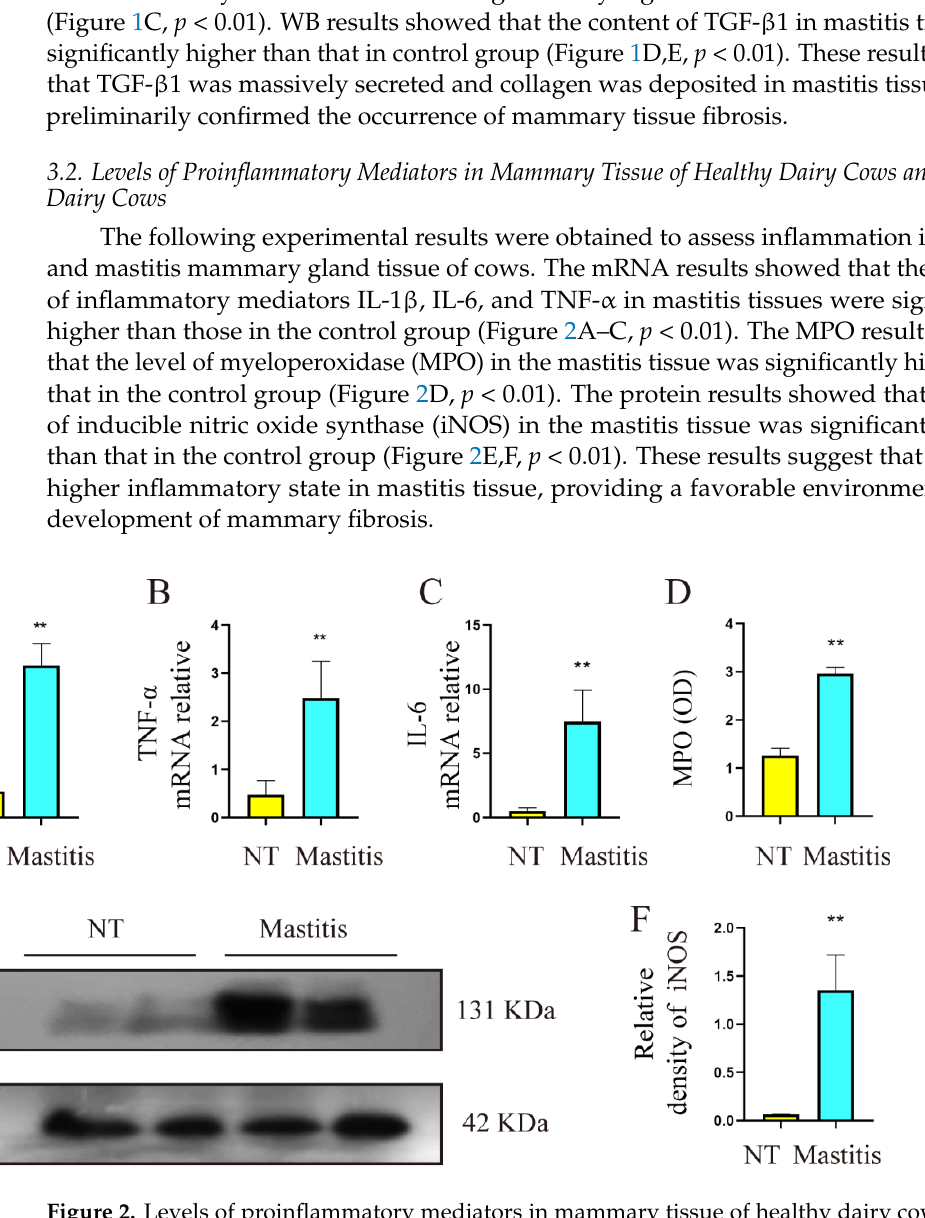
Figure 2. Levels of proinflammatory mediators in mammary tissue of healthy dairy cows ( n = 10) and mastitis cows ( n = 10). ( A – C ) The mRNA expression levels of IL-1 β , TNF- α , IL-6 in mammary tissues. ( D ) The relative change trend of MPO in mammary tissues. ( E ) The protein levels of iNOS and β -actin in the mammary gland. ( F ) Quantification of TGF- β 1 protein levels in mammary tissue, relative to β -actin. Data were analyzed by the unpaired t -test method. The data error is presented in the form of mean ± SEM. The results of the experiment are the result of three independent repeated experiments. ** p < 0.01 compared with the control group.